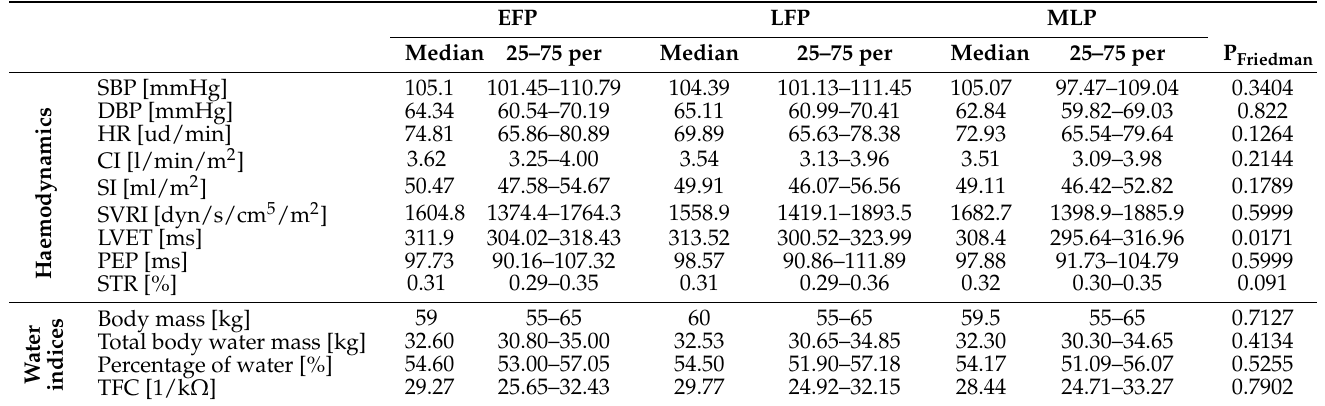
Table 2. Haemodynamic profile and indices of body water amount in healthy women during